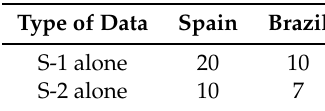
Table 4. Number of top important features selected for predictions for the Spanish and Brazilian case studies.